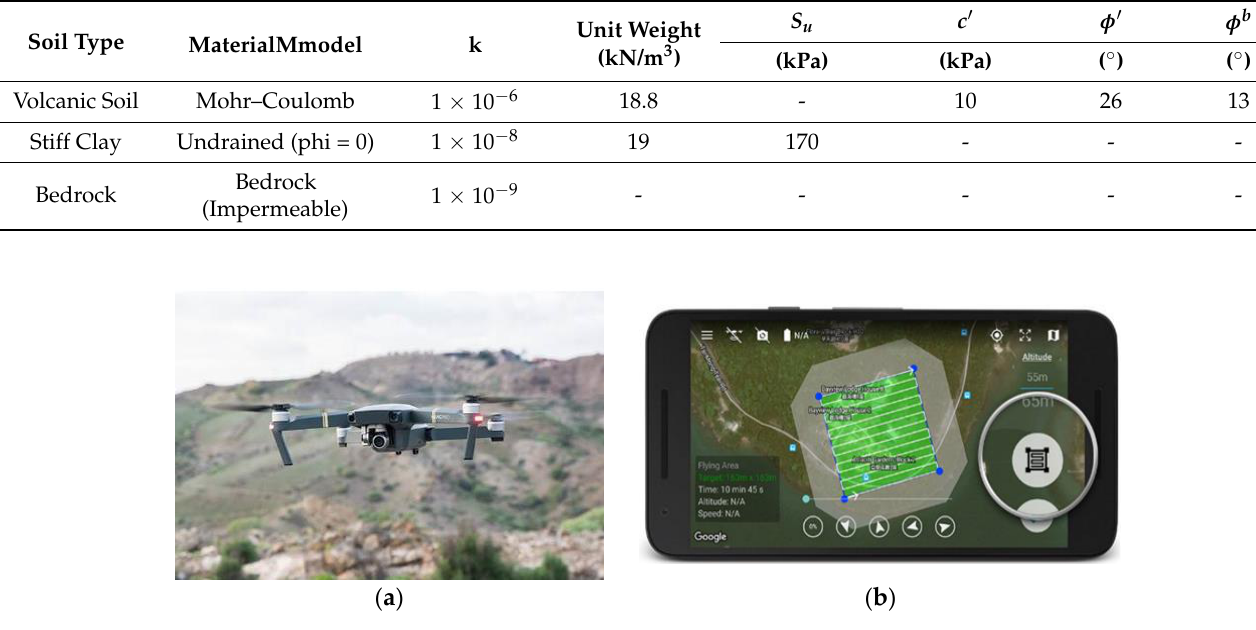
Figure 7. Drone overview. (( a ) drone; ( b ) orbit plan or flight pattern on grid).